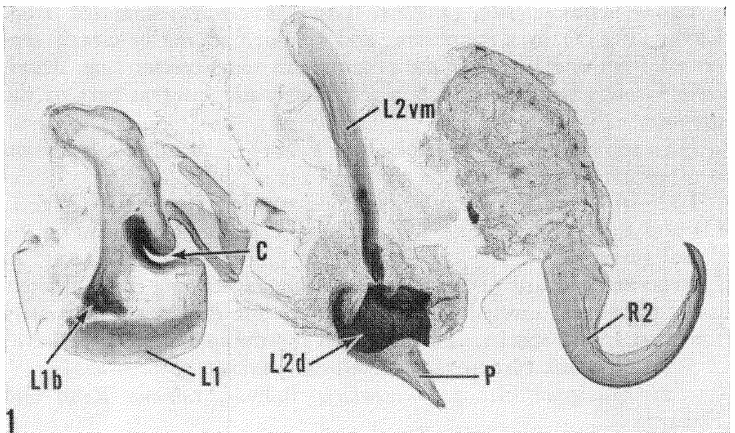
--- median sclerite